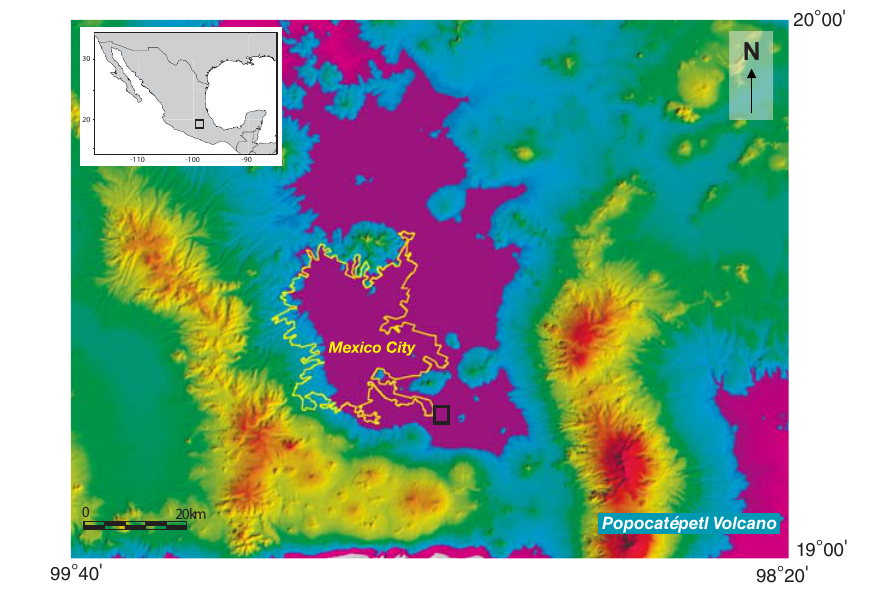
Figure 1. Location map of the Basin of Mexico, showing the location of previous coring at paleolake